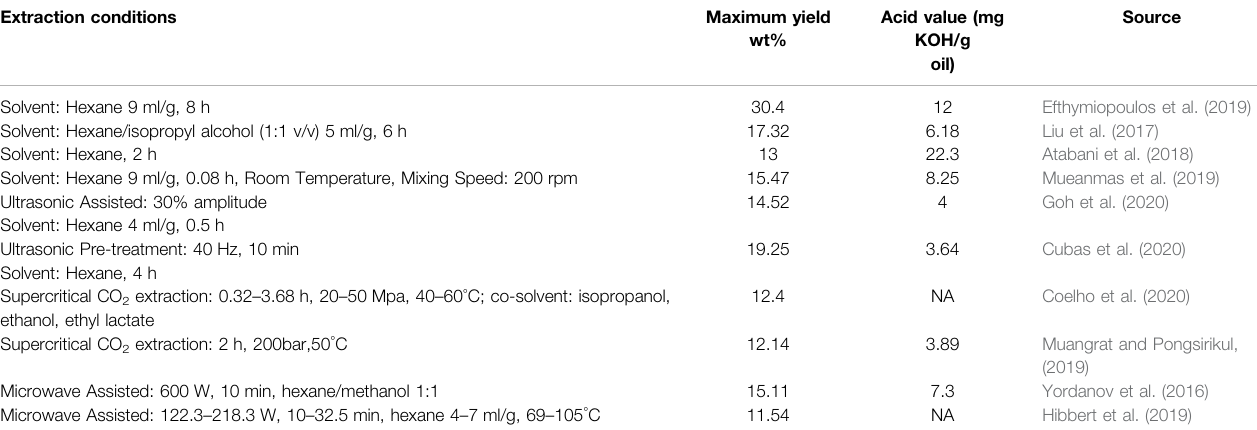
TABLE 3 | Recent studies on solvent extraction of oils from SCGs. Extraction